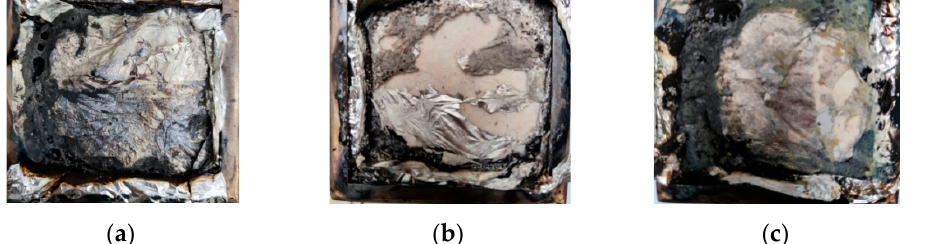
Figure 8. THR of different materials. TTI determined the flammability of polymer under actual fire conditions. The igni- tion time of each material ranged between 31 and 36 s. Moreover, resin materials were easier to ignite, and it took 6–8 min for each material to burn completely until it self-extinguished. HRR and THR are important for estimating the combustion safety of polymers. Both these parameters represent the thermal feedback generated in the material combustion process. The larger the HRR and THR, the more intense the pyrolysis process; however, it also results in worsening the safety. According to the test results, the time for base as- phalt, epoxy resin, and epoxy asphalt to reach the peak of HRR was 100, 70, and 60 s, respectively. It was easier for the resin materials to reach the combustion conditions, and the peak heat release rate (pkHRR) and THR of epoxy resin were the highest, reaching 1015.7 kW/m 2 and 104.5 MJ/m 2 , respectively. The HRR curve presented sharp peaks. Although the pkHRR and THR of base asphalt were the lowest, that is, 328.8 kW/m 2 and 50.5 MJ/m 2 , respectively, the combustion curve was relatively smooth, indicating that the epoxy resin combustion was more intense, and the base asphalt combustion was less in- tense. 3.2.2. Combustion Smoke Release Performance of Different Materials SPR, TSR, CO production rate (COP), and CO 2 production rate (CO 2 P) of different materials are shown in Figures 9–12.